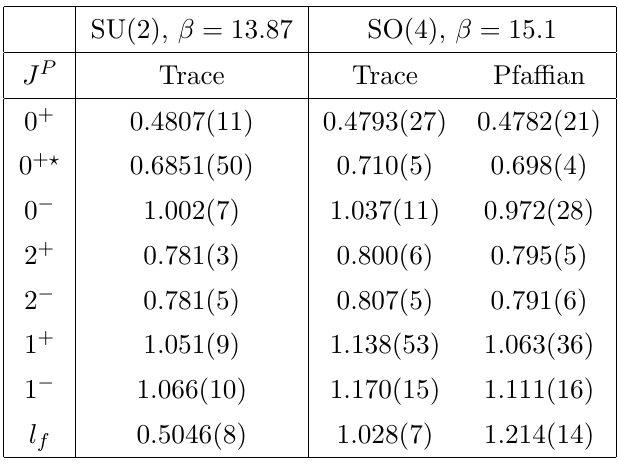
Table 2 . Lightest glueball masses SU(2) and SO(4) on a 50 2 56 lattice at the couplings shown for various spins J and parity P . Also shown is the energy of the lightest fundamental (cid:13)ux tube, l f , winding around a periodic spatial